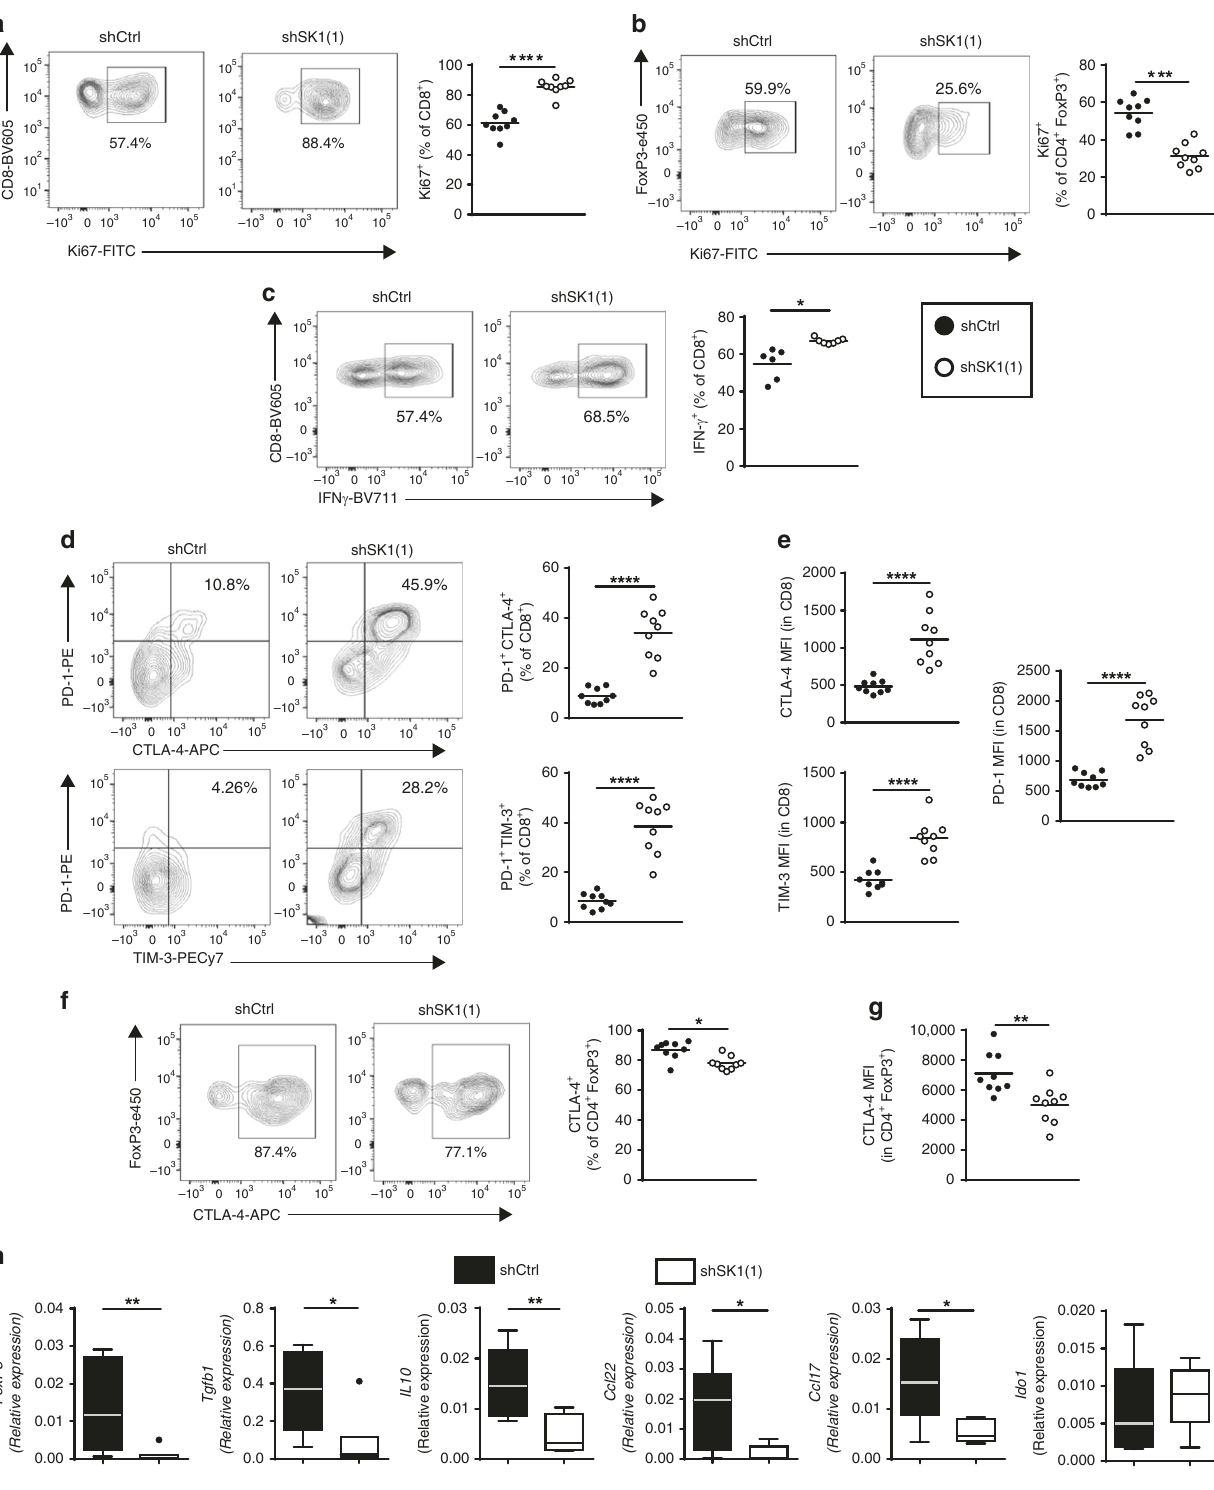
Fig. 3 SK1 silencing reduces Treg accumulation in tumors. Control shRNA (shCtrl; black points) or SK1-targeted shRNA (shSK1(1); white points) Yumm melanoma cells were injected intradermally in C57BL/6 mice, and TIL content was analyzed by fl ow cytometry on day 11 ( n = 9 mice/group). Percentages (%) of CD8 + T cells ( a ) and Treg cells ( b ) expressing Ki67. c Proportion of IFN γ + CD8 cells after PMA and Ionomycin stimulation. d Percentage of PD-1 + CTLA-4 + (upper panel) and PD-1 + TIM-3 + (lower panel) cells. e MFI of CTLA-4, PD-1 and TIM-3 among CD8 + TILs. Percentage ( f ) and Mean Fluorescence Intensity (MFI; g ) of CTLA-4 in Treg. Each symbol represents an independent tumor ( n = 9). h Levels of Foxp3, Tgfb1, Il10, Ccl17, Ccl22 and Ido1 transcripts in shCtrl (black boxes) or shSK1(1) (white boxes) tumors were quanti fi ed by RT-qPCR. The bottom-most and topmost horizontal lines, the lower and upper hinges, and the middle line of the boxplots indicate the minimum and maximum values, the 25th and 75th percentiles, and the median, respectively. Results are representative of two independent experiments ( n = 8 mice/group). Samples were compared using Mann – Whitney